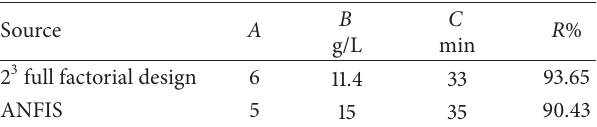
Table 5: Optimized factors and predicted removal efficiencies by ANFIS and 2 3 full factorial design.